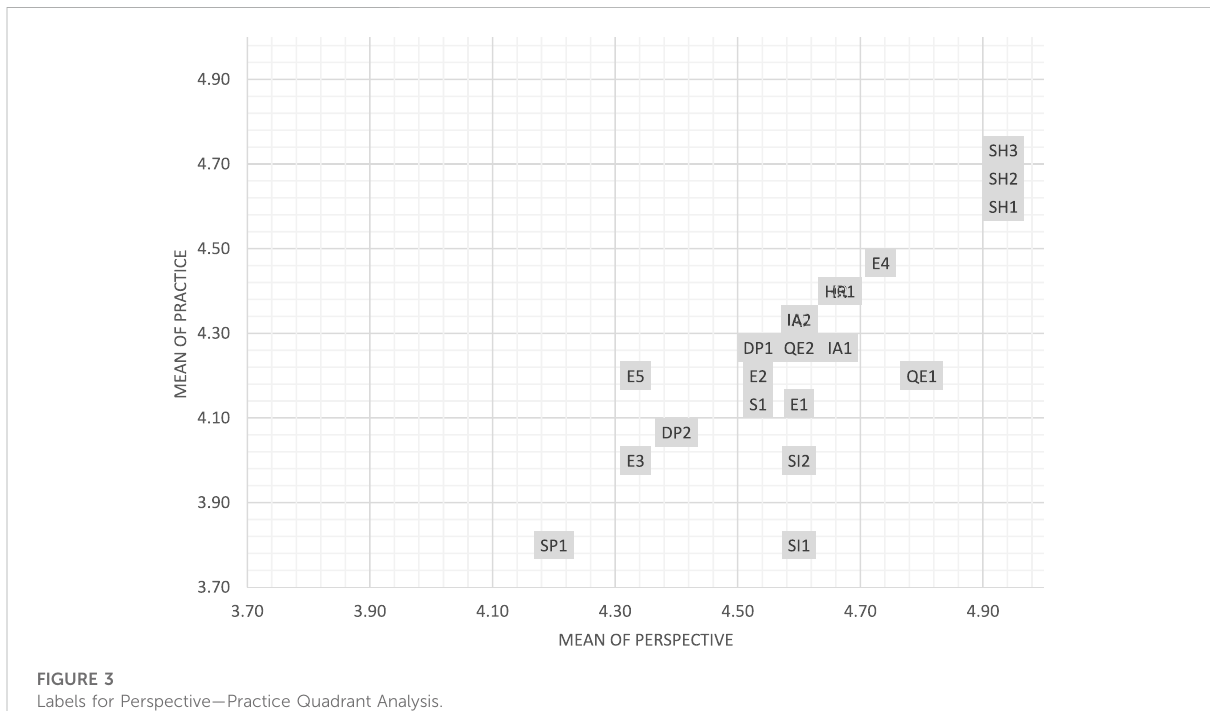
FIGURE 3 Labels for Perspective — Practice Quadrant